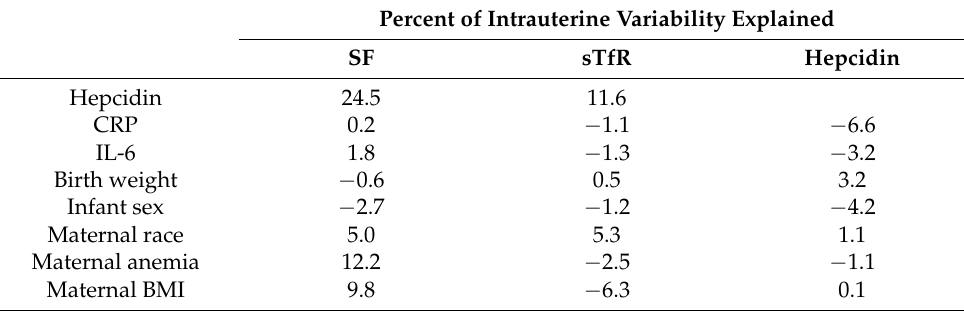
Table 4. Predictors of intrauterine variability in log-transformed iron biomarkers. Percent of Intrauterine Variability